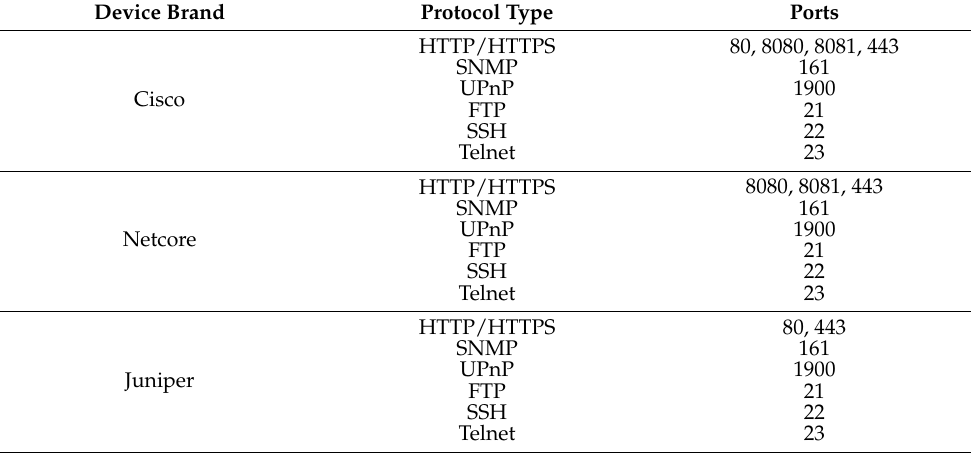
Table A3. Special Port For Router.